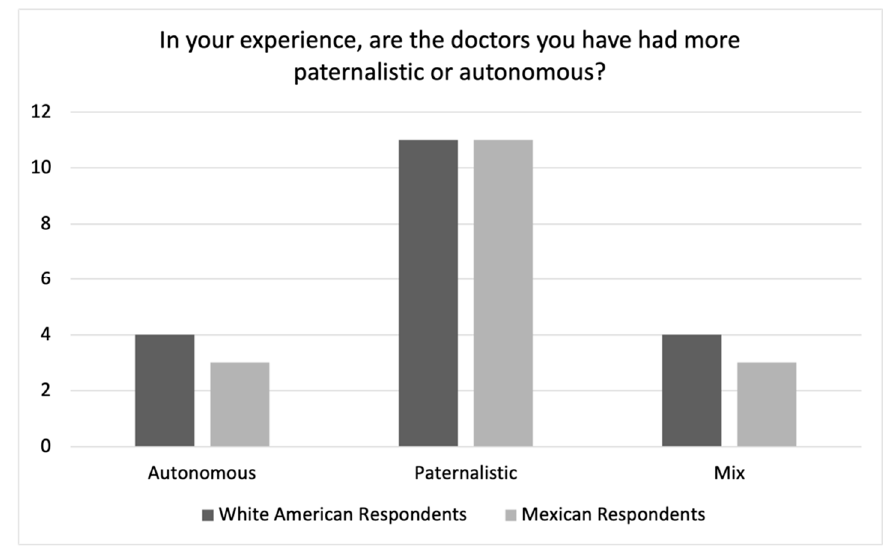
Figure 3. White American vs. Mexican Respondent Experiences.